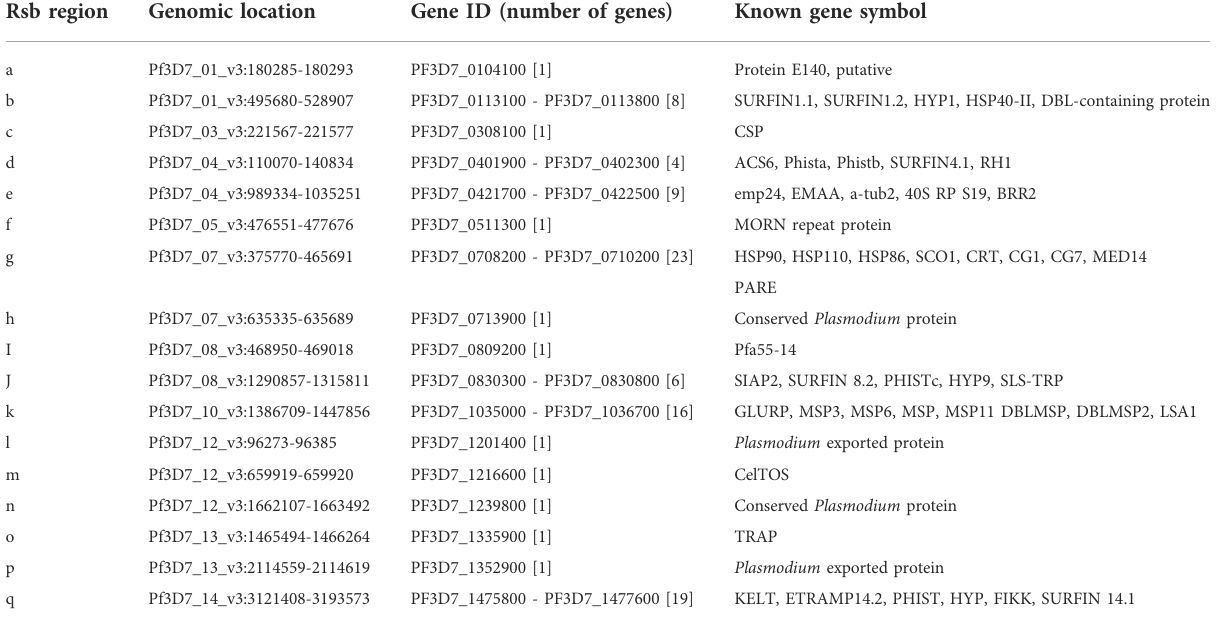
TABLE2 Plasmodium falciparum genomicregions withdifferentiatingsignatures ofpositiveselection fromFigure5C.Onlysegmentswithclustersof SNPs in selective sweep regions and between population Rsb -log10 p -value of at least 5, and the genes coded for are presented. Rsb